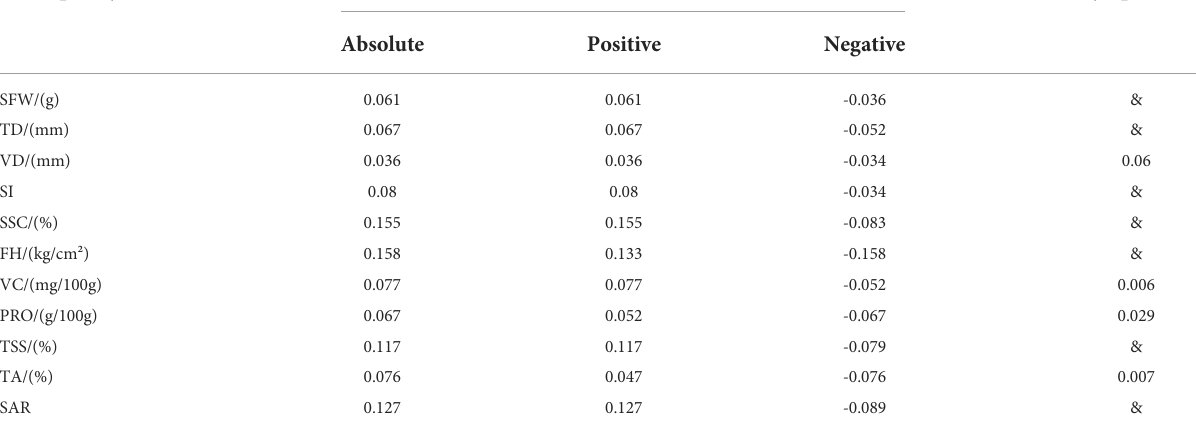
TABLE 1 Kolmogorov-Smirnov univariate normality test for fruit quality indicators. Fruit quality index